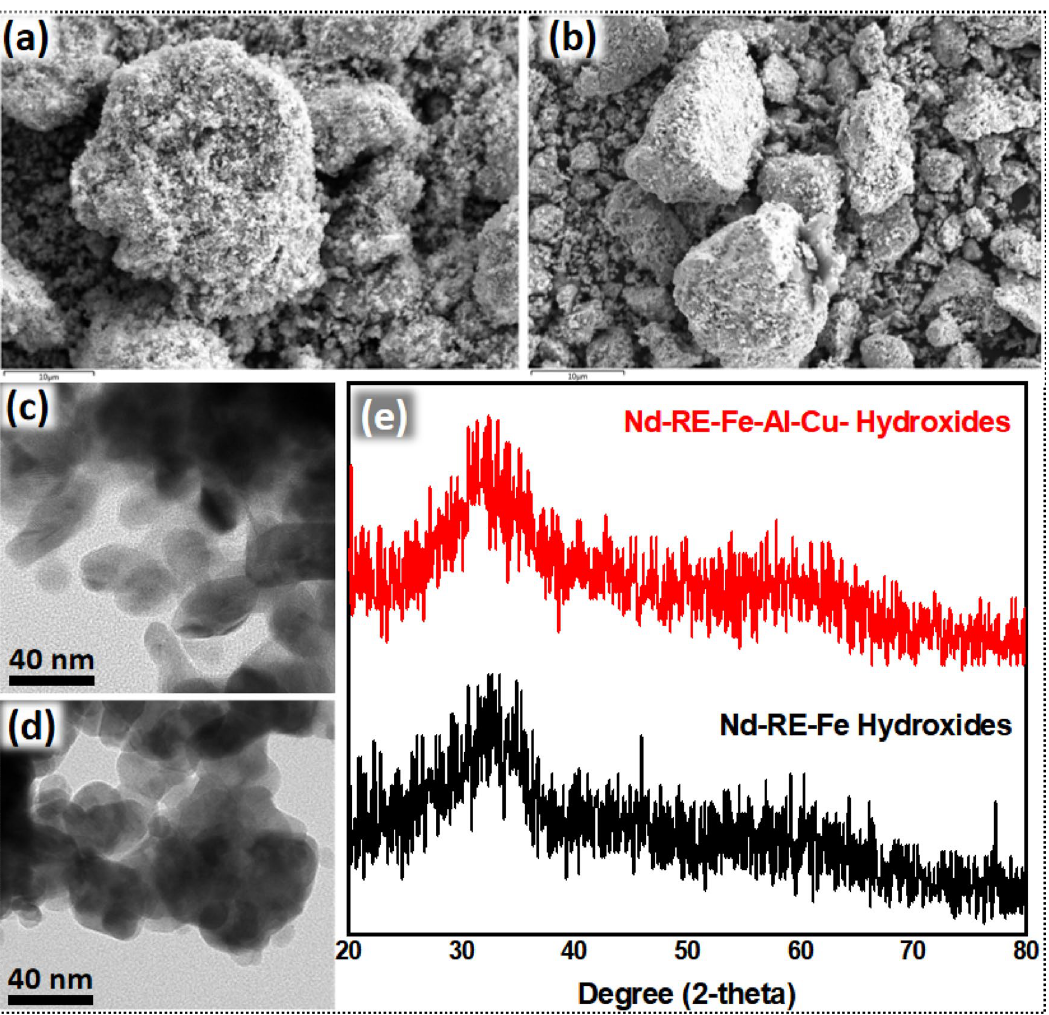
Figure 2. SEM image of hydroxide precipitates of ( a ) Nd-RE-Fe-Al-Cu and ( b ) Nd-RE-Fe. TEM image of hydroxide precipitates of ( c ) Nd-RE-Fe-Al-Cu and ( d ) Nd-RE-Fe. ( e ) XRD patterns of Nd-RE-Fe-Al-Cu and Nd-RE-Fe hydroxide